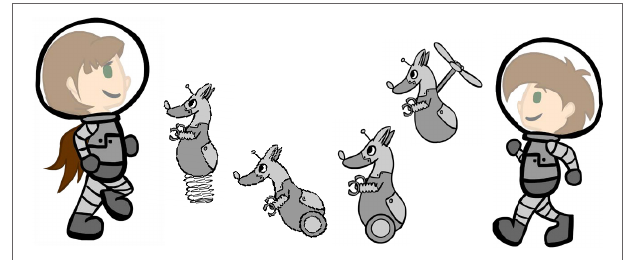
FigUre 4 | Together, the Space Explorer Hero avatar and the companion super buddy Keemo overcome many obstacles on their space mission to restore life to the barren planet and conquer the Cercer crabs before safely returning to the space station. The Space Explorer Hero is customizable for gender, and Keemo has multiple mobility options, all of which are used during gameplay to overcome different obstacles during the